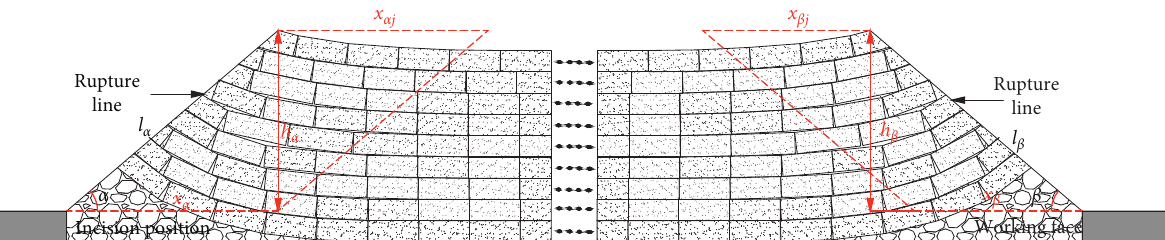
Figure 7: Simplified model of the asymmetric-oblique-quadrilateral fracture development zone in overlying